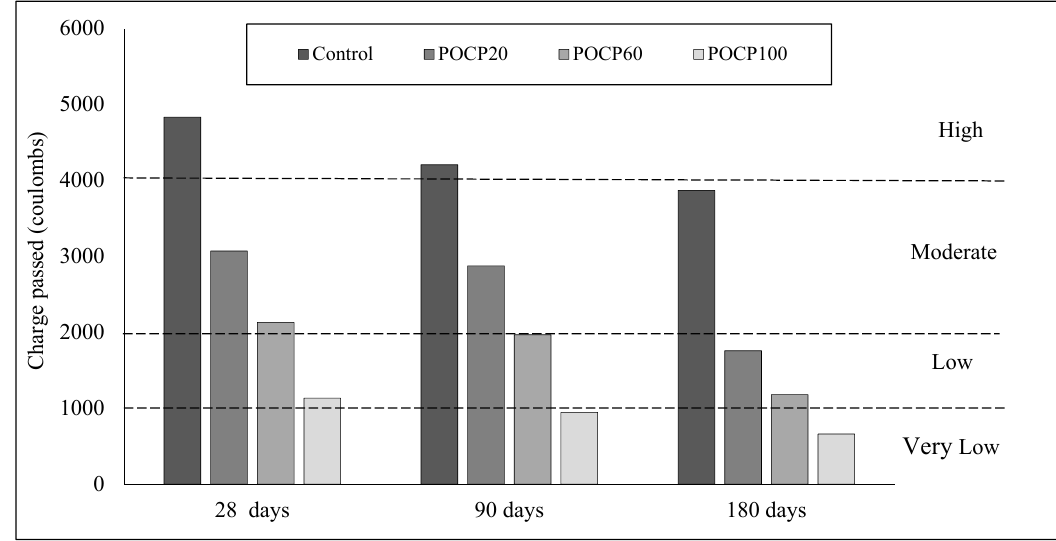
Figure 31. Charge passed coulombs value of POCP concretes.